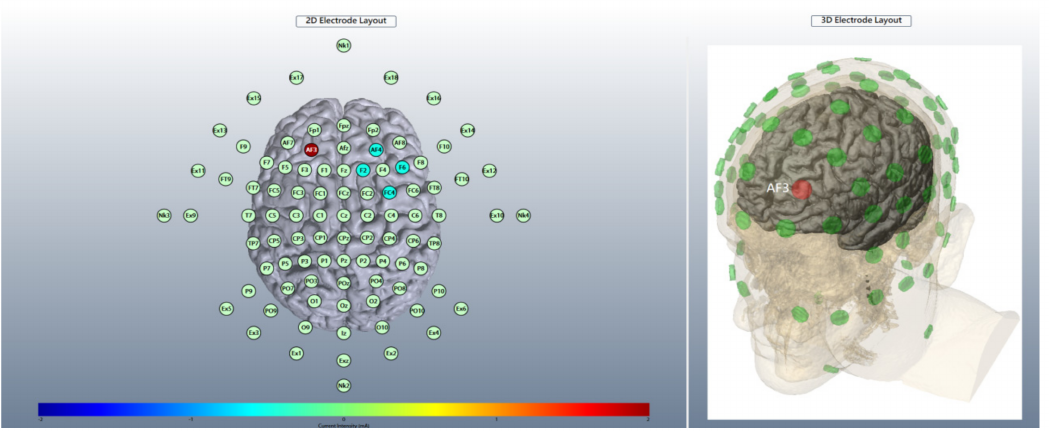
Figure 1. The left panel represents the 2D electrode layout of high-definition high-frequency tran- scranial random noise stimulation (hf-tRNS) over the lateral prefrontal cortex. According to the International 10–10 electroencephalogram electrode position, the anode (red) was placed at AF3 (current intensity: +2 mA) and the cathodes (cyan) were placed at AF4 ( − 0.5 mA), F2 ( − 0.5 mA), F6 ( − 0.5 mA), and FC4 ( − 0.5 mA). The right panel is the corresponding 3D electrode layout of the anode (red) AF3. The figure was created using HD-Explore ® software (Soterix Medical, New York, NY,